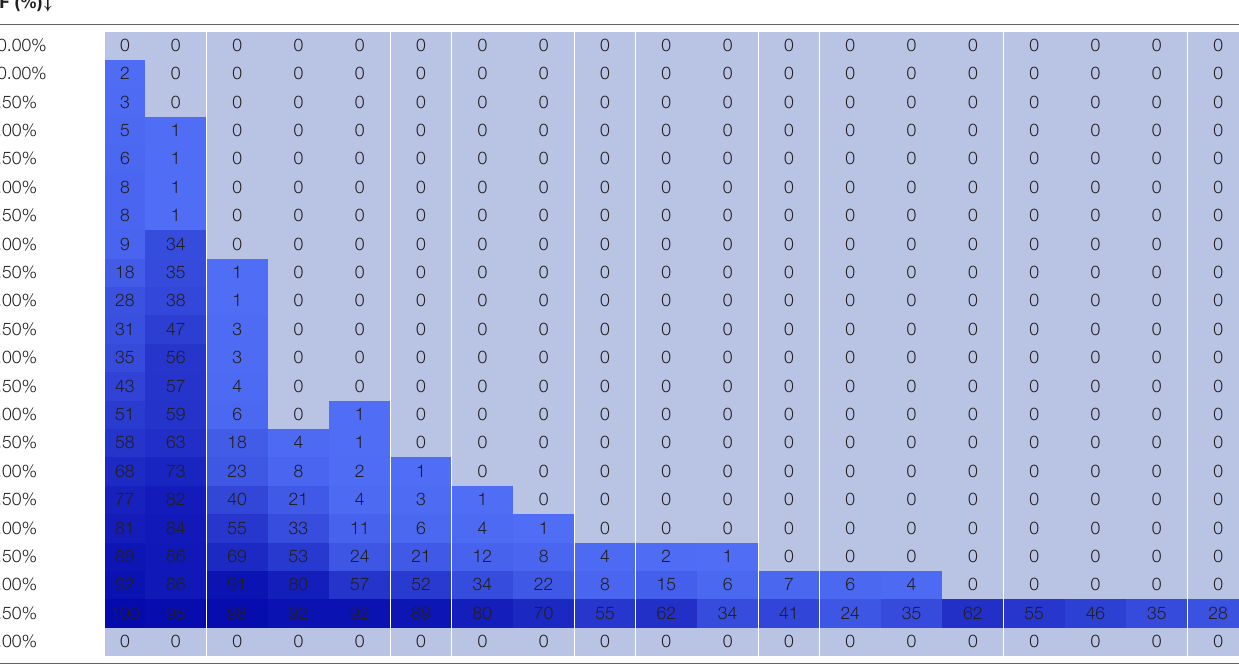
TABLE 4 | Qualitative evaluation of Dataset 2 based on false negative proportions per condition until a targeted mutant AF of 20%. Coverage → AF (%)